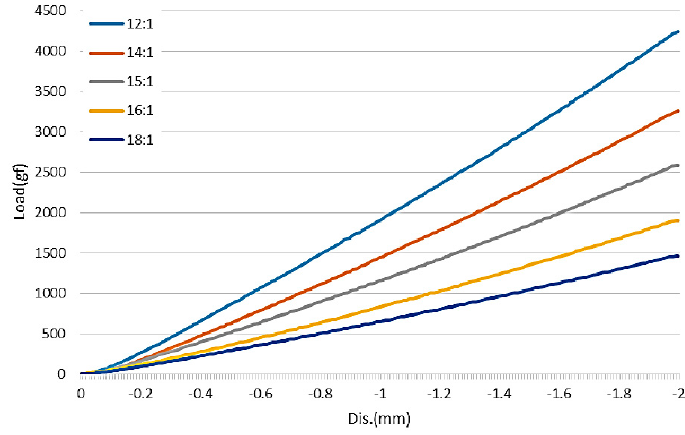
Figure 2. Results of stress-strain analysis of PDMS materials in different weight ratios.